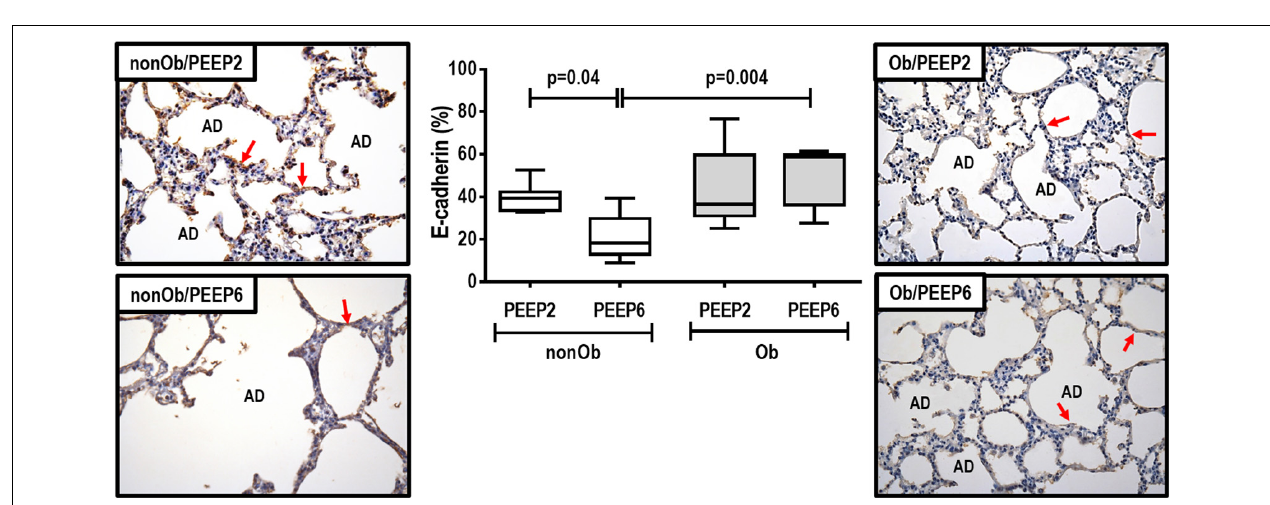
FIGURE 1 | Lung morphometry in mechanically ventilated non-obese (nonOb) and obese (Ob) groups: Low-PEEP (2 cmH 2 O) and High-PEEP (6 cmH 2 O). Fraction area of alveolar collapse and lung hyperinflation. Boxes show the interquartile range (25th–75th percentile), while whiskers encompass the range (minimum-maximum) and horizontal lines represent the median in seven animals/group.